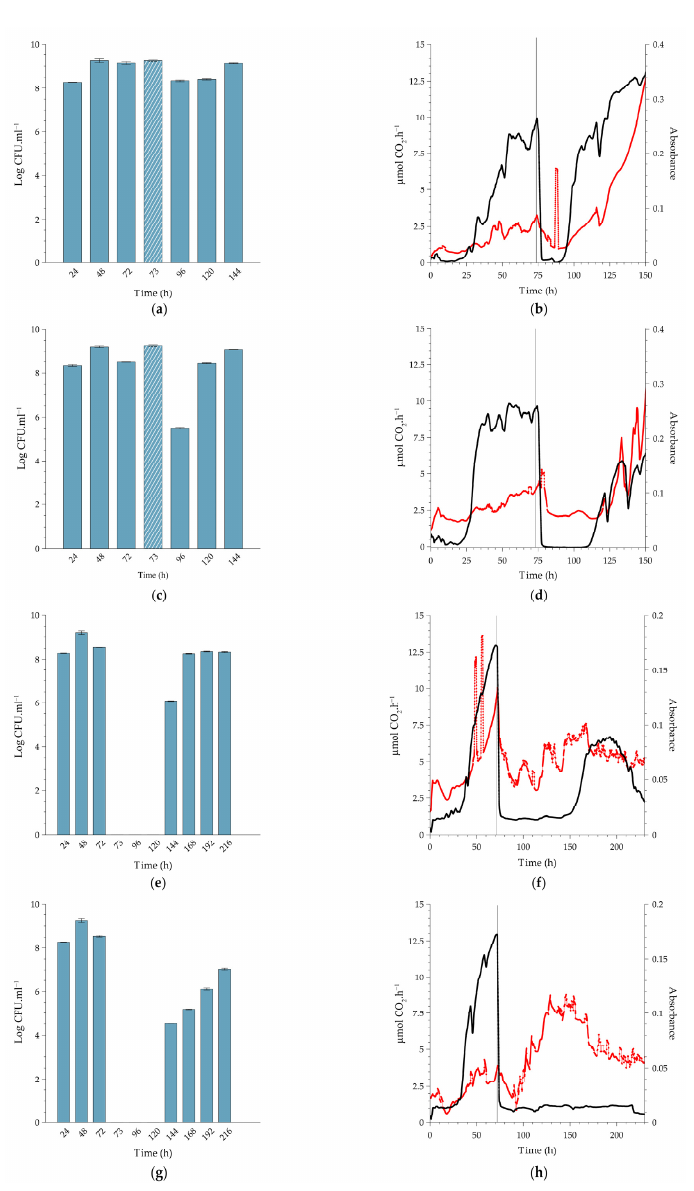
Figure 5. Sessile growth of L. monocytogenes serovar 1 / 2 a EGD-e at 37 ◦ C (body temperature), exposed to a single (slug) dose of peracetic acid (PAA) for a 20-min dosing period under continuous flow conditions. Planktonic cell yields from sessile communities were determined before and after dosing with increasing concentrations of PAA; ( a ) 0.16% PAA (MIC), ( c ) 0.5% PAA (minimum recommended concentration), ( e ) 1.5% PAA (10-fold increase from MIC) and ( g ) 4.0% PAA (maximum recommended concentration). Cross-hatched bars represent planktonic cell yields 1 h after dosing (73 h) of the sessile communities. All data are a representation of biological duplicates. Each bar represents the logged mean of triple plate counts, with the error bar representing the standard deviation. Changes in biofilm metabolic activity (black line) and biofilm biomass (red line) were monitored in real-time with a dosing period indicated by the vertical black line at 72 h. Changes in biofilm metabolic activity (black line) and biofilm biomass (red line) were monitored in real-time, with the dosing period indicated by a vertical black line at 96 h. Biofilms were dosed with increasing concentrations of PAA; ( b ) 0.16% PAA (MIC), ( d ) 0.5% PAA (minimum manufacturer recommended concentration), ( f ) 1.5% PAA (10-fold increase of MIC), and ( h ) 4.0% PAA (maximum manufacturer recommended concentration). Figure 5b,d,f,h are representative data from duplicate biofilms. Each bar in Figure 5a,c,e,g represent the average of triplicate plate counts of duplicate biofilms, and error bars indicate the standard